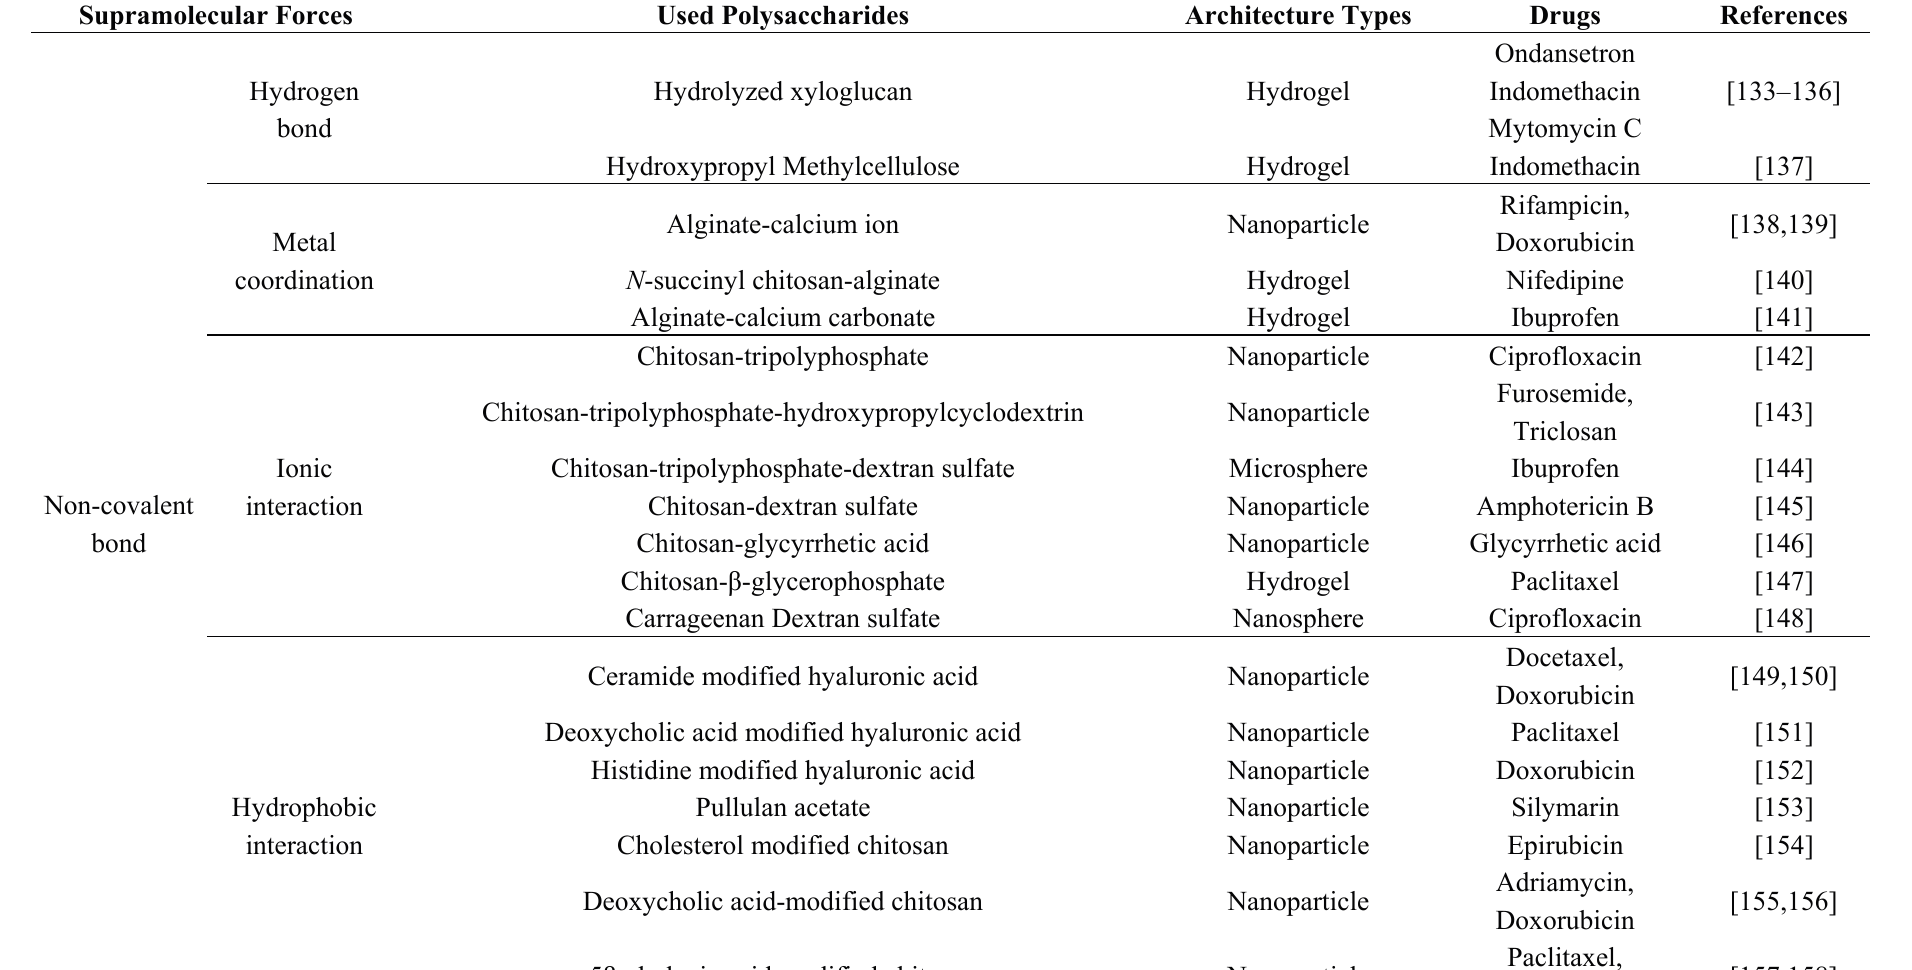
Table 1. Polysaccharide-based carriers for the bioavailability enhancement of poorly soluble